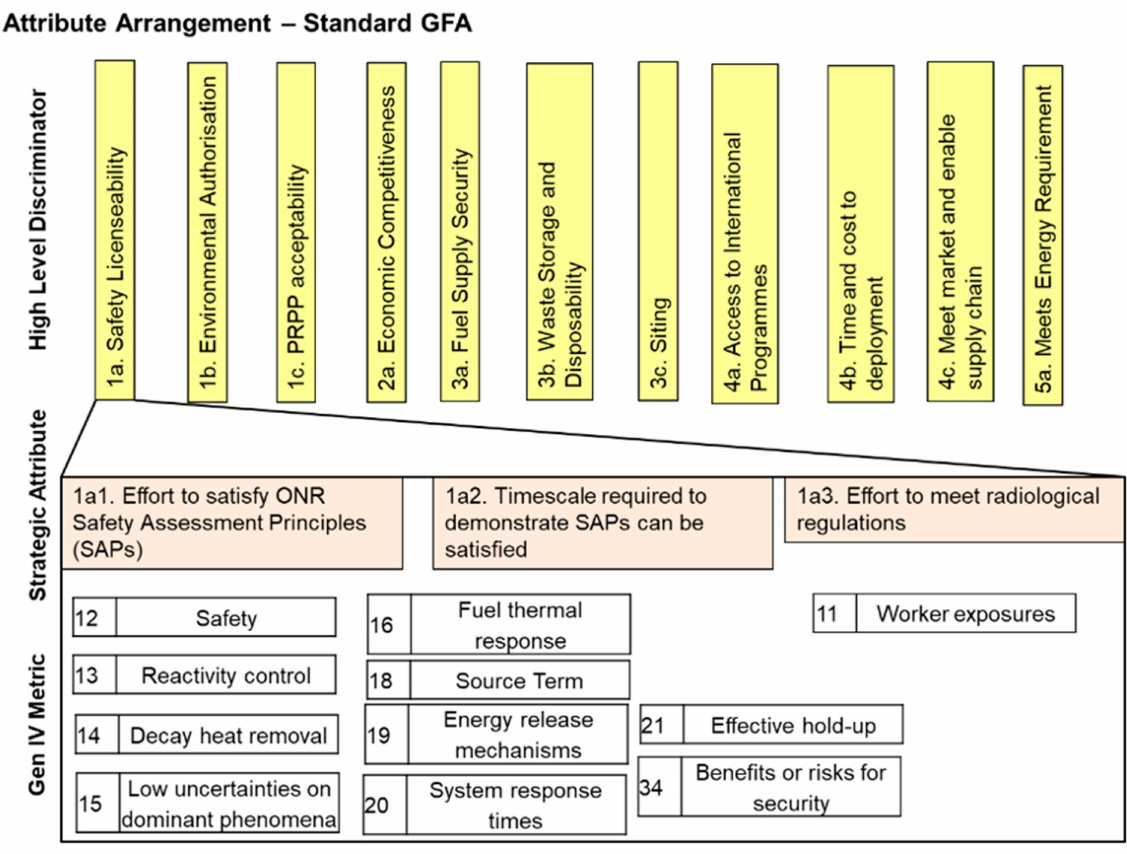
Figure 4. Attribute Chain from Gen-IV metric to High Level Discriminator (Safety and Licenseability